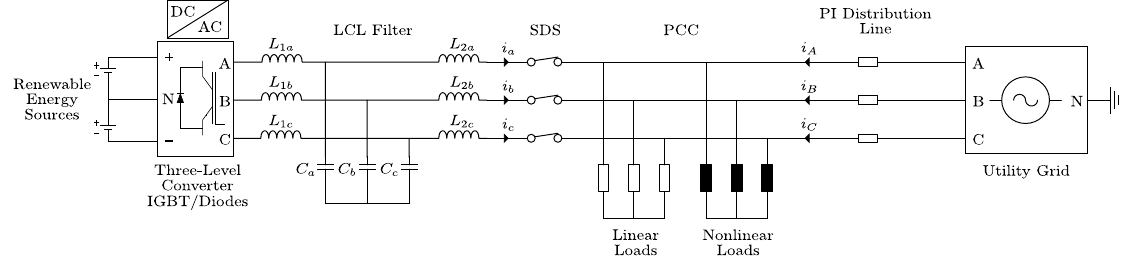
Figure 2. The Microgrid structure used in this work. CSI and LCL filter compound the operational controlled current